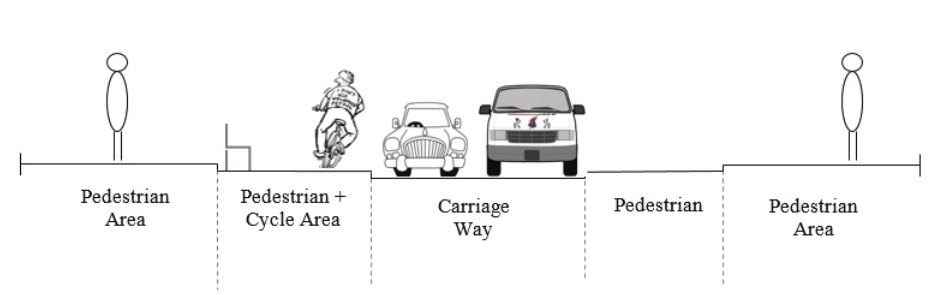
Figure 8. Cross section of Byng place,